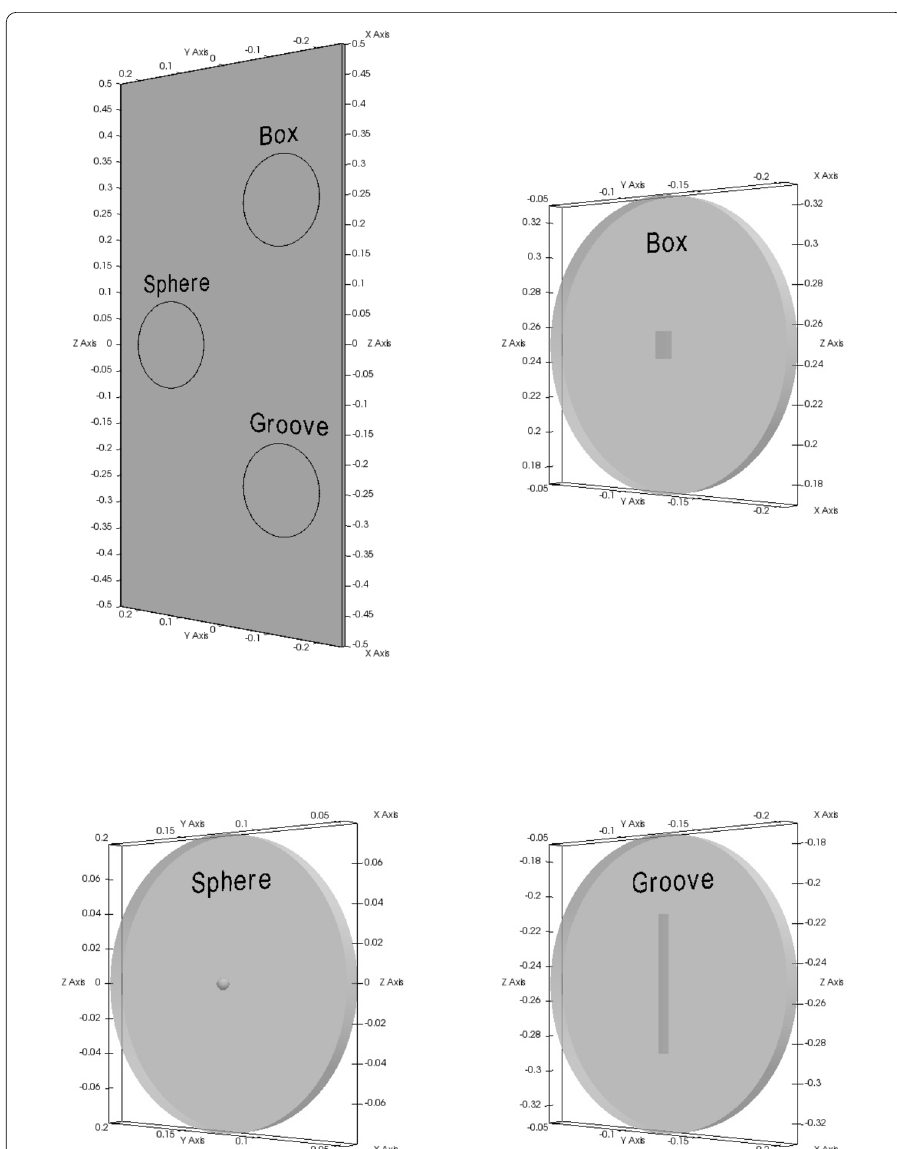
Figure 3 Faulty plate. Plate and three zoomed regions that contain the defects